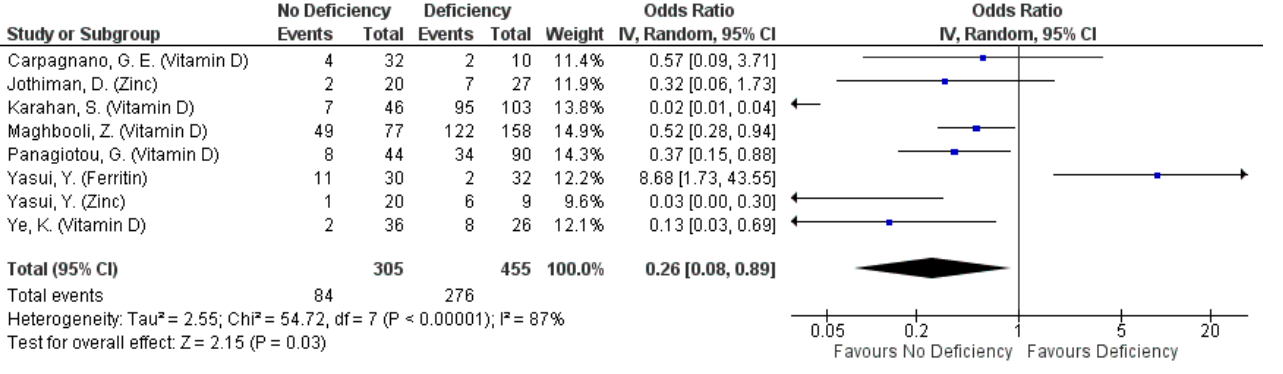
Figure 7. Pooled odds ratio on clinical deterioration of COVID-19 patients (defined by severe/critical clinical condition or ICU admission) hospitalized subjects are not deficient, compared to those deficient in any micronutrient singly.